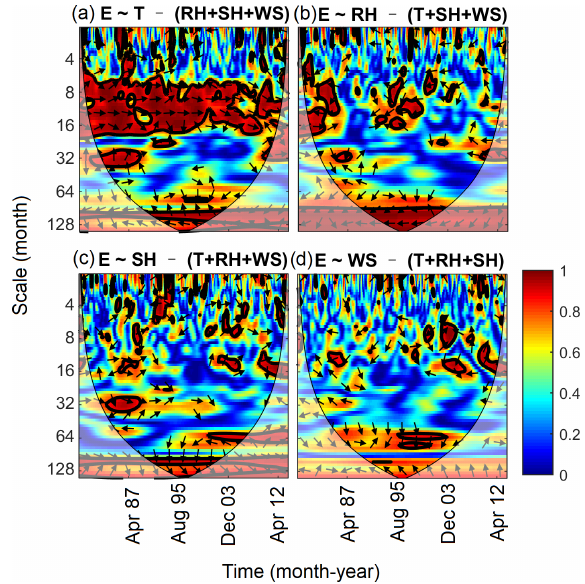
Figure 4. PWC between evaporation ( E ) and each meteorological factor ( T , mean temperature; RH, relative humidity; SH, sun hours; WS, wind speed) after excluding the effects of all three other fac-